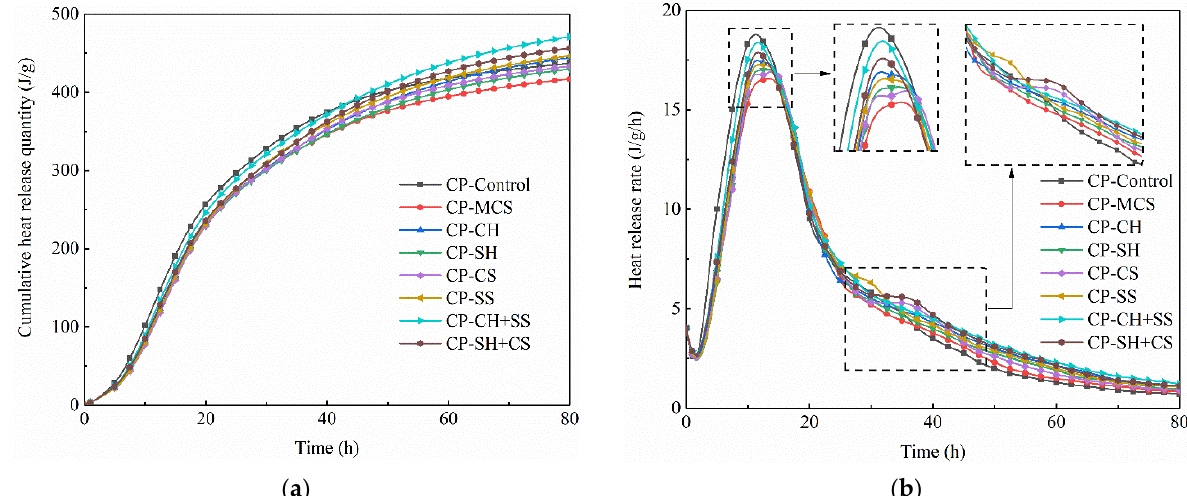
Figure 9. Hydration heat release curves of cement paste: ( a ) cumulative heat release quantity of cement paste, ( b ) heat release rate of cement paste.